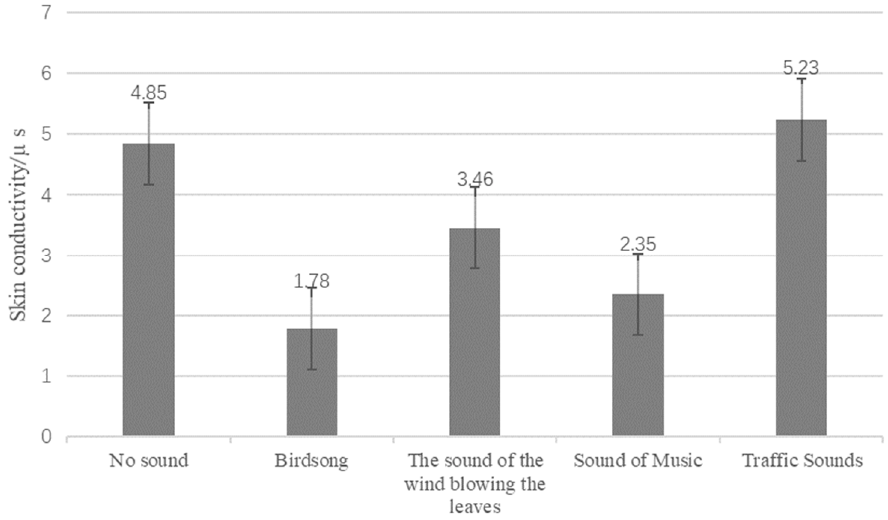
Figure 7. Changes in SCL after different types of sound stimulation.